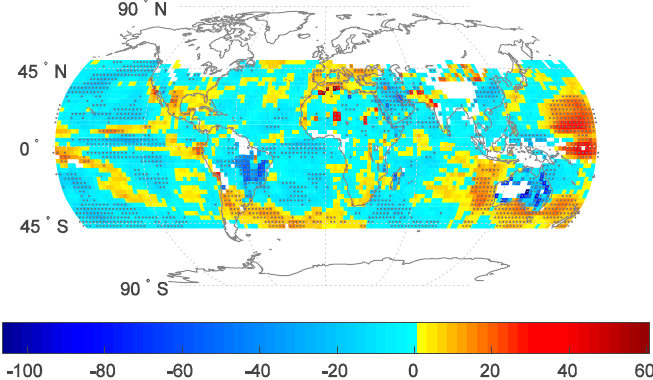
Figure 1. Tendencies of model-computed downward surface solar radiation anomalies (changes in surface solar radiation (SSR), in W m − 2 ) during the period 2001–2009. Dots indicate geographical cells for which the SSR tendencies are statistically significant.